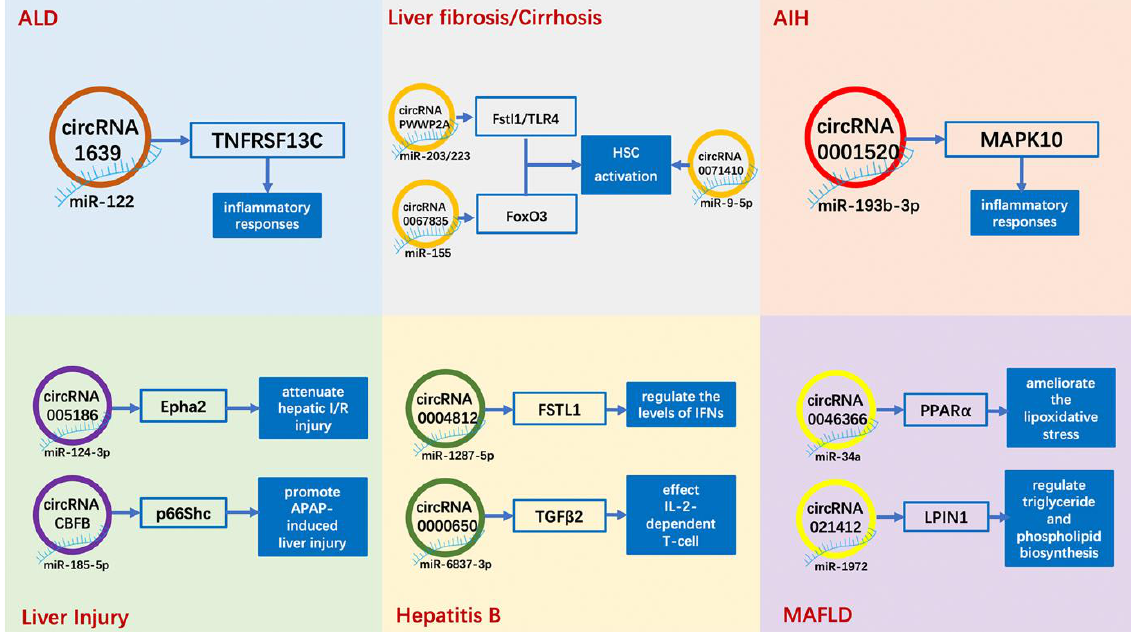
Figure 3. Examples of circRNAs in chronic liver diseases . ALD: alcoholic liver disease; MAFLD: metabolic-associated fatty liver disease; AIH: autoimmune hepatitis; HSC: hepatic stellate cell; I/R: ischemia/reperfusion; APAP: acetaminophen; IFN: interferon.